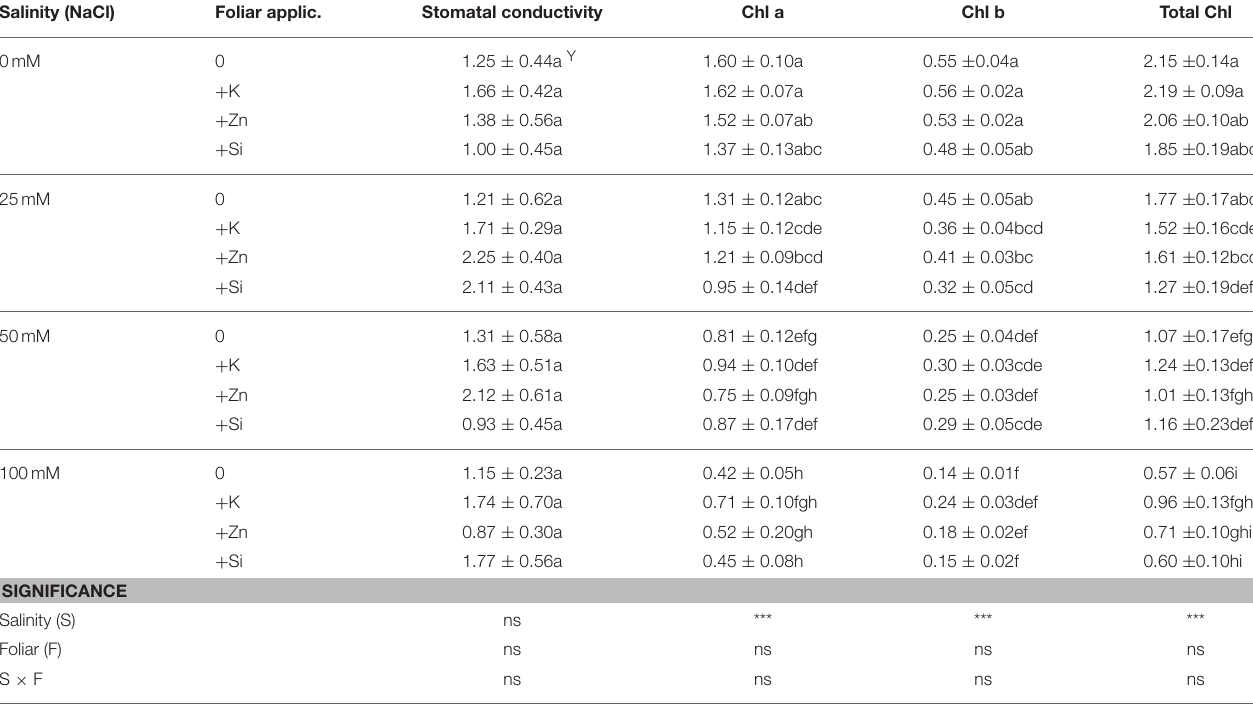
TABLE 3 | Effect of salinity levels (0–25–50–100mM NaCl) and foliar applications (no foliar, K, Zn, and Si) on lavender leaf stomatal conductivity (cm/s), chlorophylls (Chl a, Chl b, Total Chl) content (mg/g fresh weight) in plants grown hydroponically in perlite. Salinity (NaCl) Foliar applic.